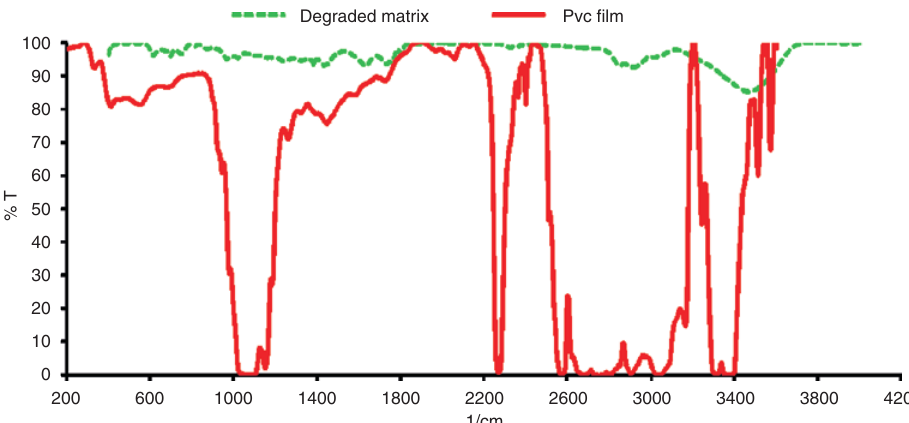
Figure 10: FTIR spectra of untreated PVC film and degraded PVC